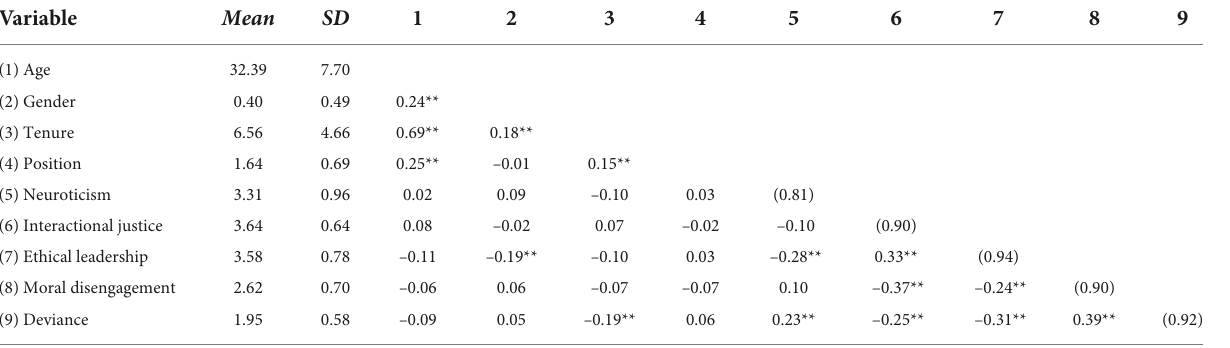
TABLE 1 Means, standard deviations, coefficient alphas, and correlations. Variable